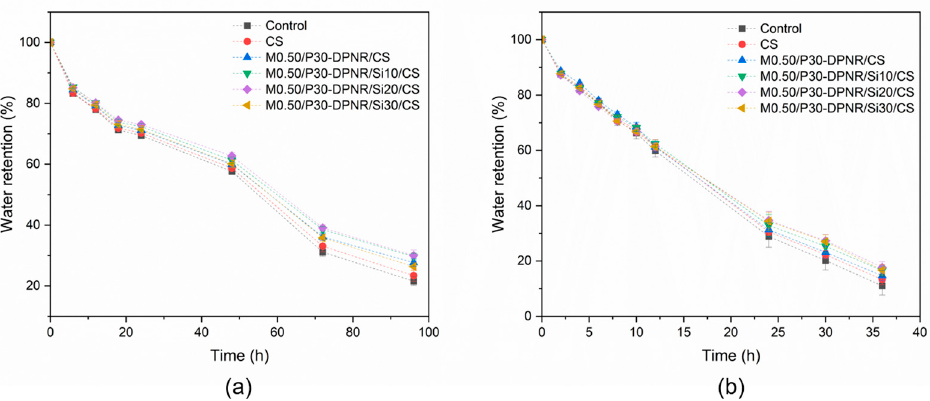
Figure 13. Water retention of di ff erent types of natural rubber/silica-coated CS beads at di ff erent temperatures: ( a ) 25 °C; ( b ) 45 °C. temperatures: ( a ) 25 ◦ C; ( b ) 45 ◦